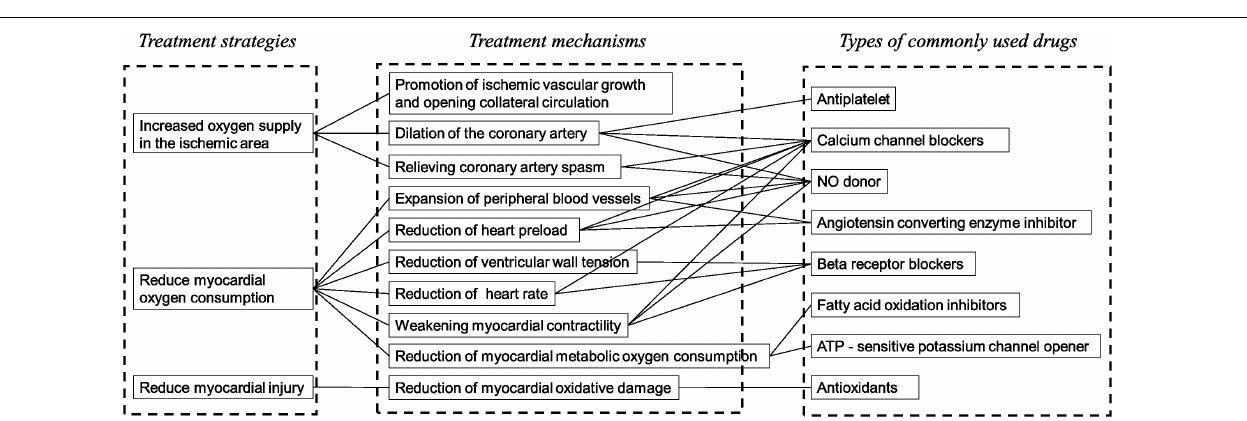
FIGURE 1 | The Schisandra three-mode GOI network analysis workflow. (A) The components in the Schisandra extract were identified through HPLC-Q-TOF-MS-MS. Target proteins relevant to component (T C ) were then obtained through PharmMapper. AMI related differential expressed genes (T AMI ) and pharmacological effect related proteins (T E ) were screened through data mining from three different databases (B) . After target data were enriched through the GO annotation database, the relationship between the component and pharmacological effects were connected through GO terms, and the “component–gene ontology–effect” three-mode network was constructed. The relation score between component and effect was calculated using a maximum flow algorithm. In the end, the prediction results were validated through pharmacological experiments (C) , with the corresponding drug given to mice one day after ligation of the left anterior descending.